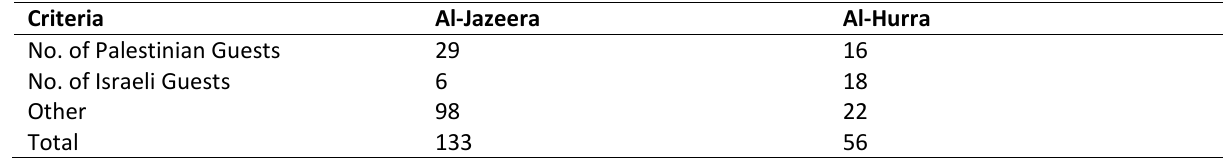
Table 1. The number of guests on each channel’s news bulletin.